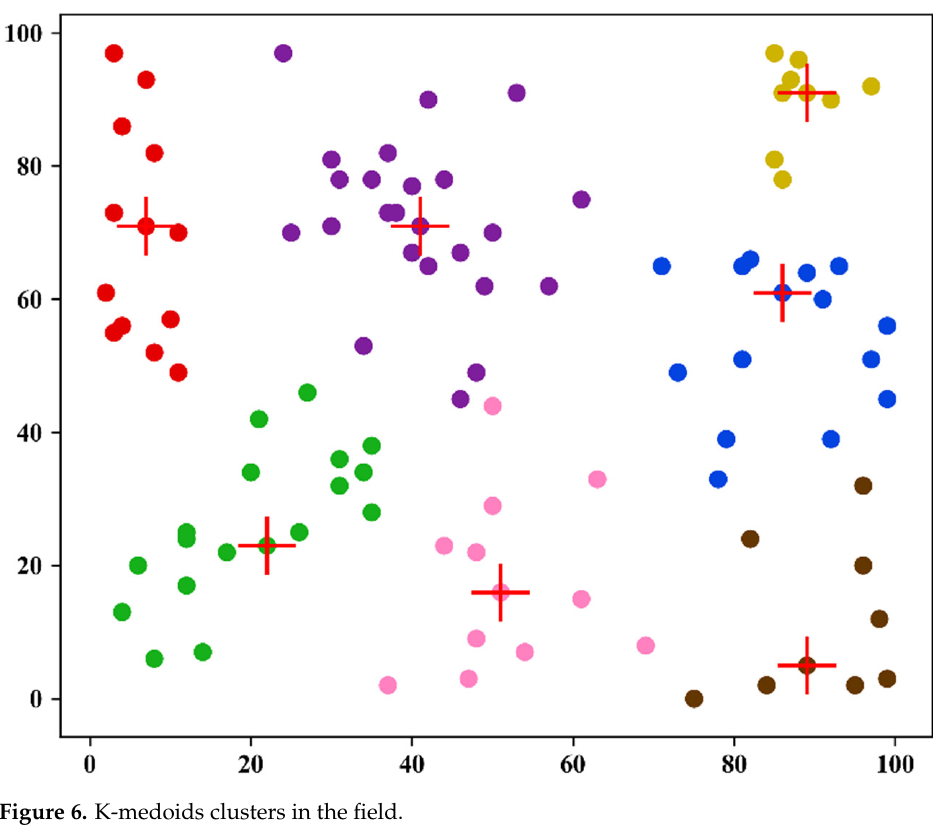
Figure 6. K-medoids clusters in the field.